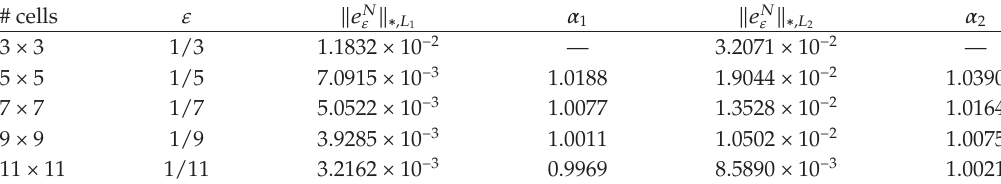
Table 1: Comparison of solutions to the macro-model with those to the micro-model for di ff erent values of ε with data as in Example 3.2.